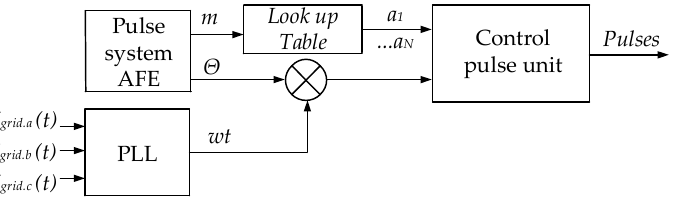
Figure 8. The structural diagram of Selective Harmonic Elimination Pulse Width Modulation.